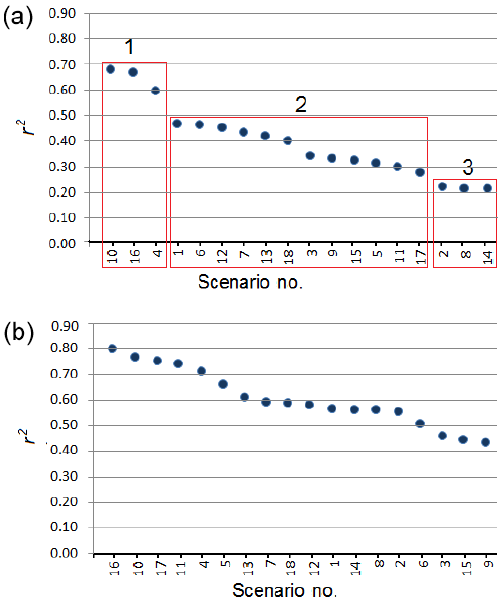
Figure 7. Values of r 2 calculated for prediction of (a) discharge and (b) sediment yield, from the 18